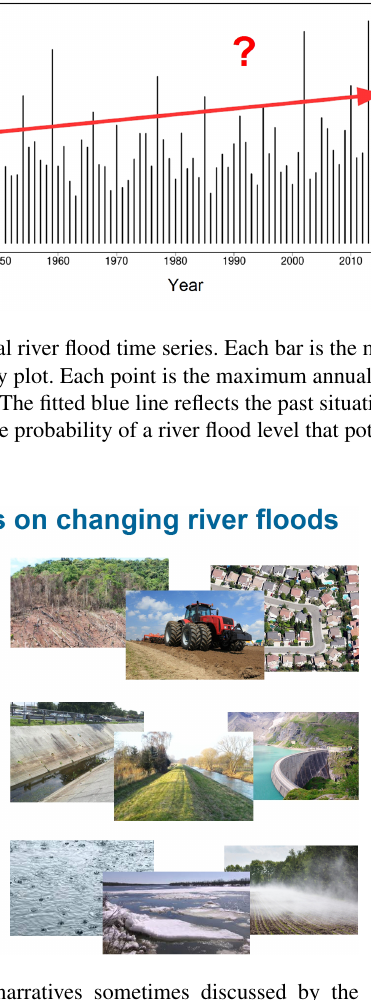
Figure 2. Starting from narratives sometimes discussed by the general public, the article addresses three hypotheses: land-use changes, such as deforestation, urbanisation and soil compaction by agriculture, increase flood hazards; hydraulic structures, such as river training, levees and dams, increase flood hazards; cli- mate change increases flood hazards through modified precipitation, snowmelt and